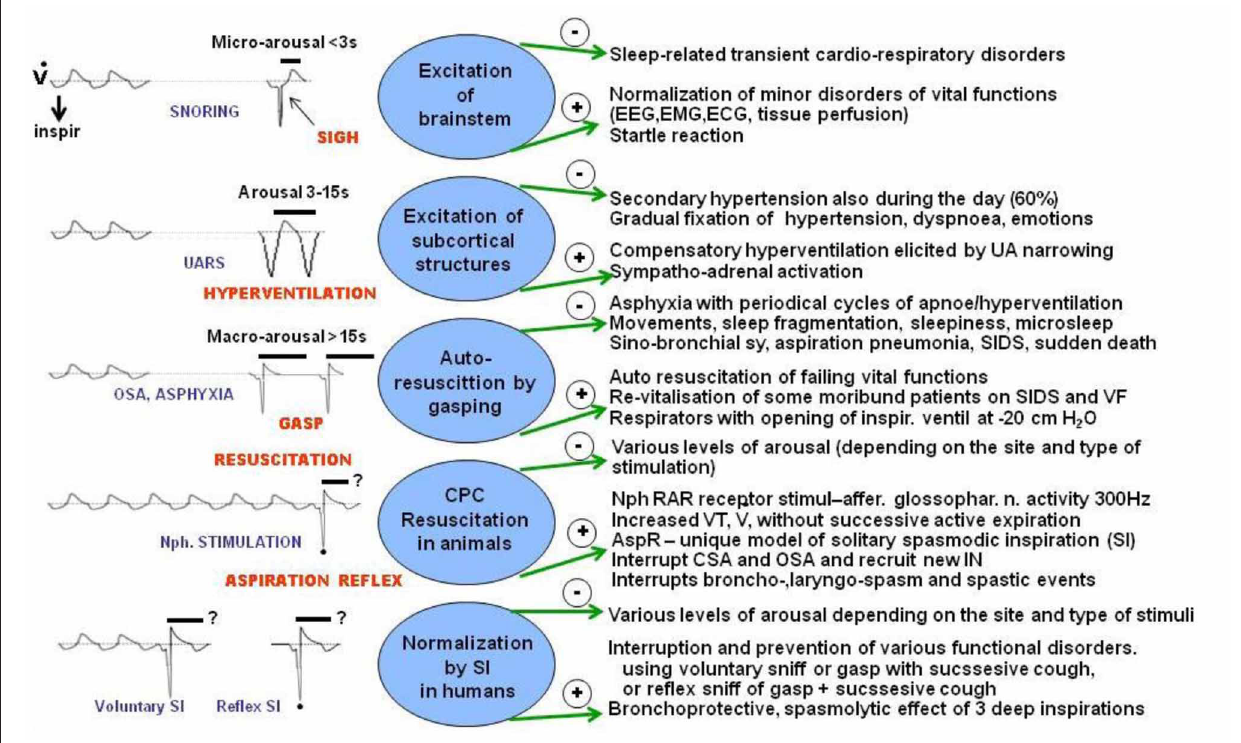
by modification of breathing coupled with arousal reactions during sleep in patients mediated by variable neuronal substrates are compared with changes provoked by AspR elicited by mechanical stimulation of nasopharynx (NPh) in anesthetized cats and with presupposed effects of reflex and voluntary spasmodic inspirations (sniffs) in